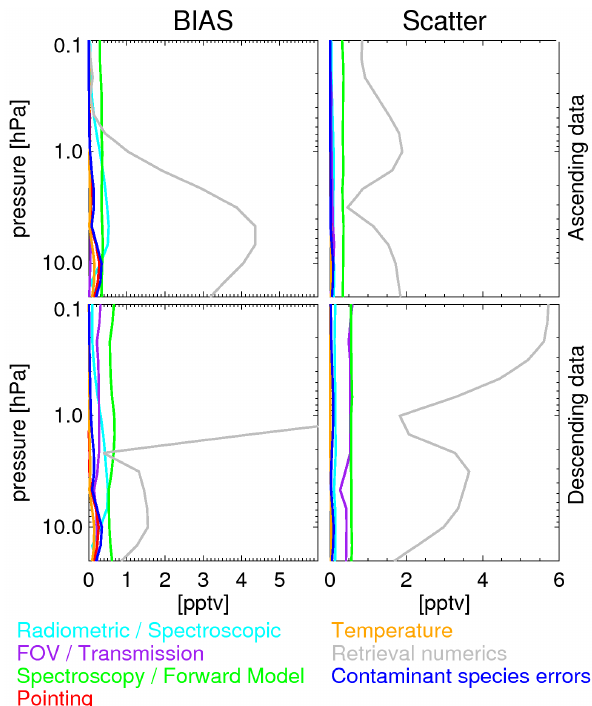
Fig. 5. Estimated impact of various families of systematic errors on the MLS OL2 BrO observations. Cyan lines correspond to uncer- tainties in the MLS radiometric and spectral calibration. Magenta lines denote uncertainties associated with the MLS FOV and an- tenna transmission efficiency. Green lines denote errors in the spec- troscopic databases and due to the forward model approximations. The impact of the uncertainties in the MLS pointing are depicted by the red lines. The yellow lines corresponds to errors in the re- trieved MLS temperature, while the blue lines show the impact of the retrieved errors in contaminant species. Errors due to retrieval formulation are shown in gray. The top panel corresponds to the as- cending part of the orbit while the lower panel corresponds to the descending part. The left panel shows the possible biases and the right panel shows the additional scatter introduced by each family of systematic